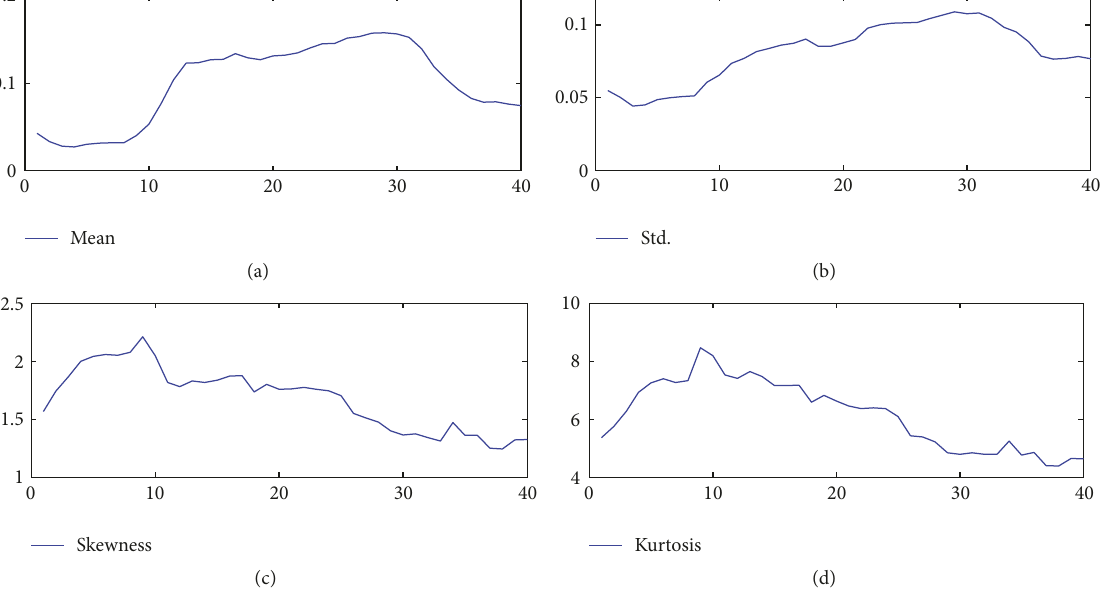
Figure 5: Statistics of the contagion strength across markets for every window. The average (a), standard deviation (Std.) (b), skewness (c), and kurtosis (d)